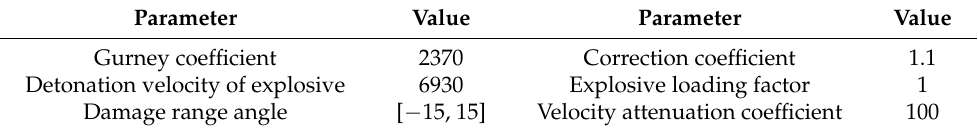
Table 2. Damage efficiency